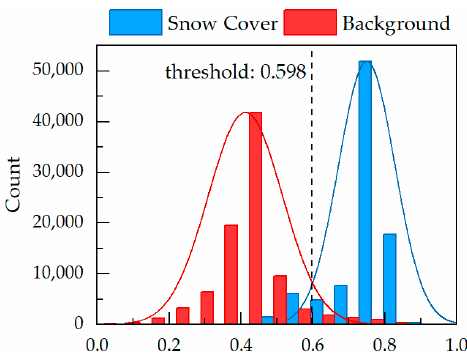
Figure 9. Histograms of the 𝑁𝐷𝑆𝐼 (cid:3045) value of the 90,000 snow cover and 90,000 background pixels. 𝑁𝐷𝑆𝐼 (cid:3045) : The normalized difference snow index (NDSI) calculated with the restored SWIR reflectance.